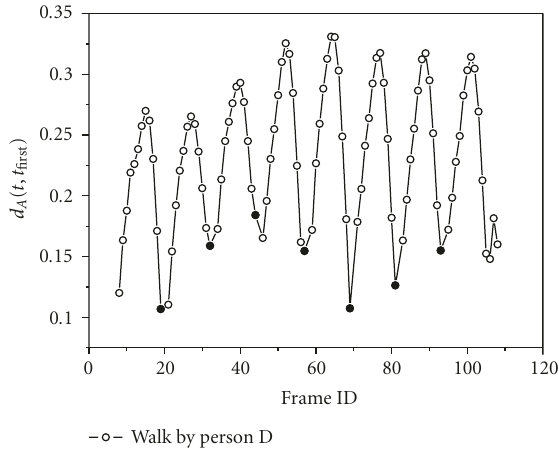
Figure 4: Atom distance d A ( t , t first ) from the first atom in its motion texton in “Walk” sequence by Person D, the black points denote the first atom in a motion texton.